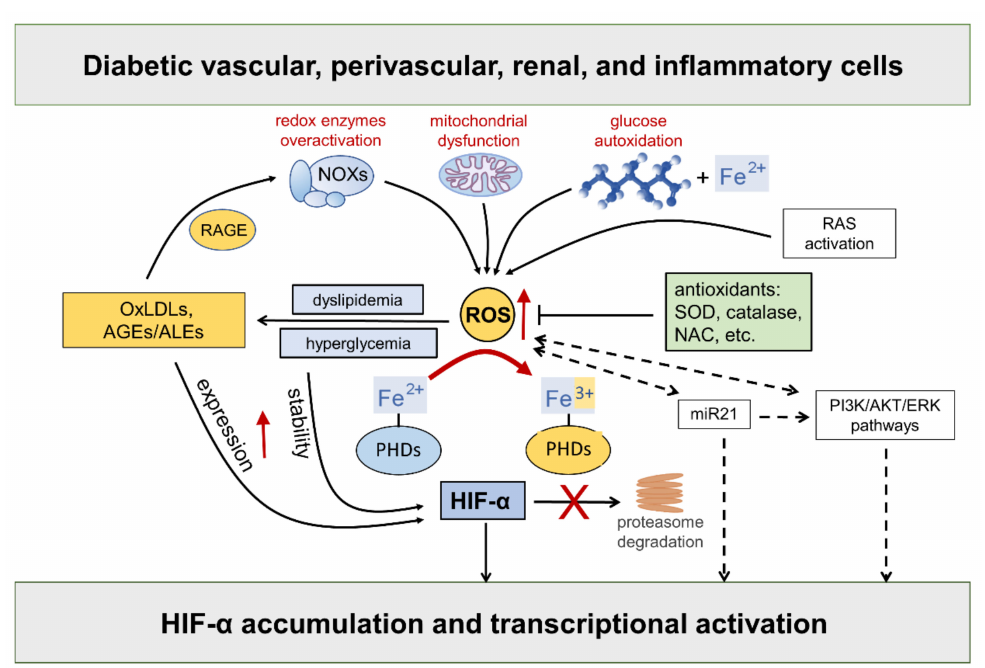
Figure 3. Hypoxia-inducible factor (HIF)- α stability is sensitive to redox status in normoxia: role of diabetes-related stimuli. Refer to the main text for detailed description and references. Dashed arrows = regulation of HIF- α by ROS via indirect mechanisms. NOXs = NADPH oxidases; RAGE = receptor for AGEs; RAS = renin angiotensin system; AGEs = advanced glycation end prod- ucts; ALEs = advanced lipoxidation end products; OxLDLs = oxidized Low-Density Lipopro- tein; ROS = reactive oxygen species; SOD = superoxide dismutase; NAC = N-acetyl-L-cysteine; PHDs = prolyl hydroxylase domain enzymes; miR21 = microRNA 21; PI3K = phosphoinositide 3-kinase; Akt = Ak strain transforming; ERK = extracellular signal-regulated kinase; PHDs = prolyl hydroxylase domain